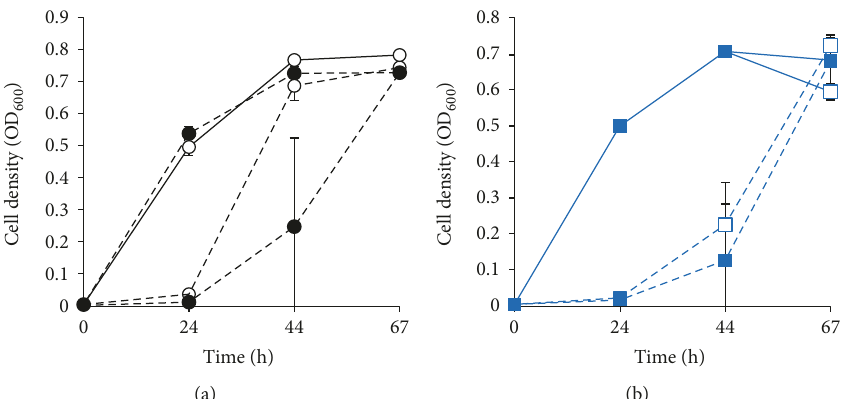
Figure 6: Growth curve of DNA photolyase-de fi cient strain after UV irradiation. Wt (SK-1) and Δ phr (DP-1) cells were irradiated with UV light (1200J/m 2 ) and cultivated in XTU liquid medium under light or dark conditions for viability testing. (a) SK-1. (b) DP-1. Open symbols: light conditions; closed symbols: dark conditions; solid lines, without UV irradiation; dotted lines: with UV irradiation. Error bars represent the standard deviation of two independent